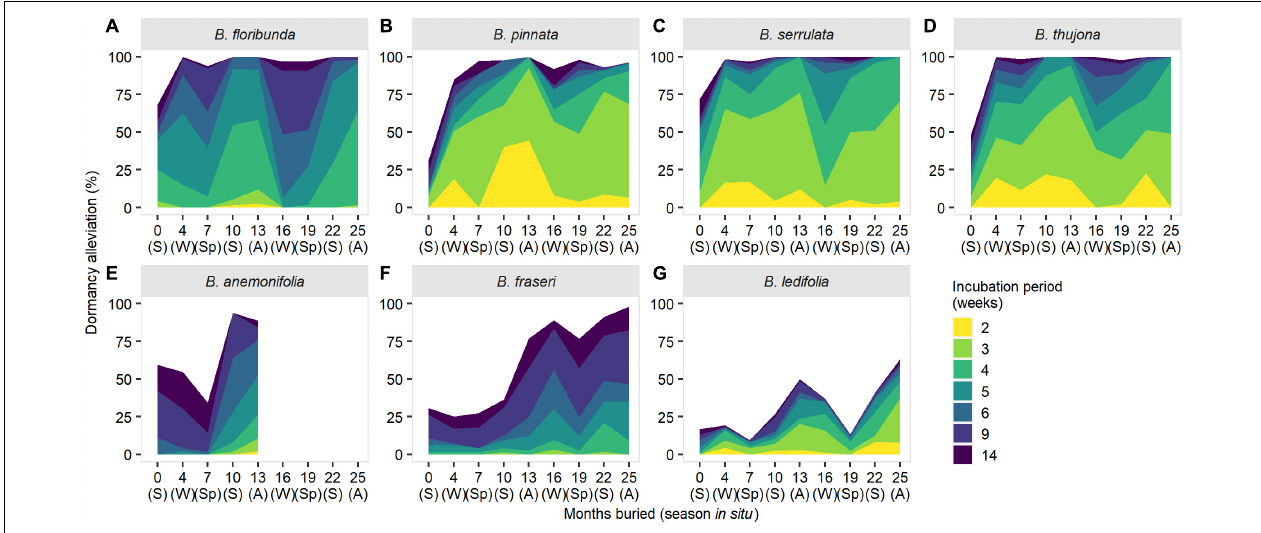
FIGURE 4 | Seasonal changes in dormancy (as measured by maximum germination response) and the effect of incubation period for seven species of Boronia (Rutaceae) from south-eastern Australia. S, summer; A, autumn; W, winter; Sp, spring. Species are arranged by sections within the genus: (A–D) Boronia ; (E) Cyanothamnus ; (F,G) Valvatae . Boronia anemonifolia was studied for 1 year only due to limited seed availability. Data for B. fraseri and B. ledifolia at 13 months have been imputed (refer to Supplementary Material 2 for